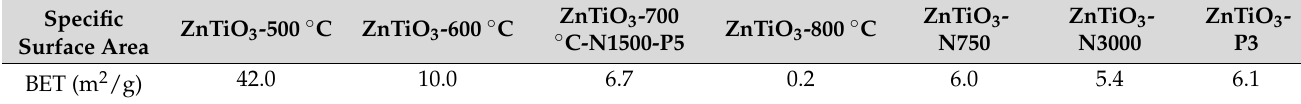
Figure 5. ( a ) The N 2 adsorption–desorption isotherms and ( b ) the pore size distribution of ZnTiO 3 prepared at 500~800 ◦ C. Table 2. BET specific surface area of ZnTiO 3 prepared in various